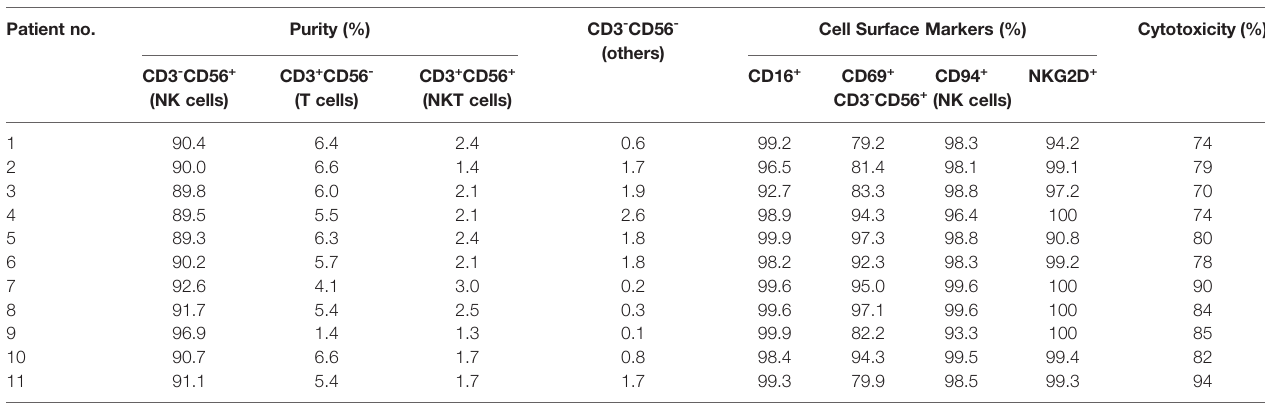
TABLE 2 | Characteristics of VAX-NK/HCC.